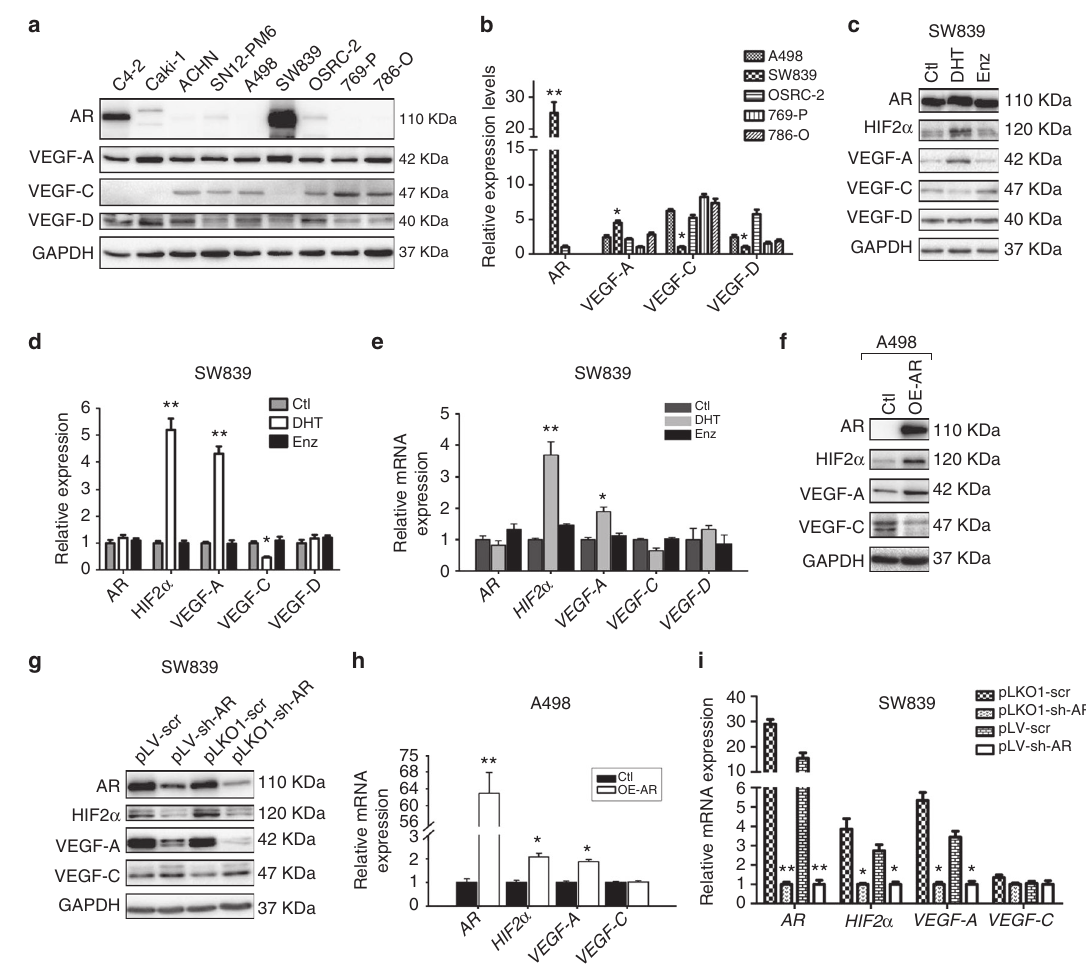
Fig. 2 AR differentially regulates the VEGF-A vs. VEGF-C in ccRCC cells. a Protein expressions of AR, VEGF-A, VEGF-C, and VEGF-D were detected by western blot in a series of ccRCC cell lines (SN12-PM6, Caki-1, ACHN, A498, SW839, OSRC-2, 769-P, and 786-O). The prostate cancer cell line C4-2 expressing AR was used as positive control. b Quantitation of protein expressions of AR, VEGF-A, VEGF-C, and VEGF-D in triplicate western blot assays of VHL mutant cell lines (A498, SW839, OSRC-2, 769-P, and 786-O). c Immunoblotting of HIF2 α , VEGF-A, VEGF-C, and VEGF-D following 48 h DHT and Enz treatment in SW839 cell line. d Quantitation of protein expressions of AR, VEGF-A, VEGF-C, and VEGF-D in triplicate western blot assay. e The mRNA levels of HIF2 α , VEGF-A, and VEGF-C following 24 h DHT and Enz treatment in SW839 cells. f Western blotting of HIF2 α , VEGF-A, and VEGF-C in A498 cells with/without AR overexpression (OE-AR). g We used two different sh-RNAs (pLKO1-sh-AR and pLV-sh-AR) to knockdown AR in SW839 cells. The results showed that both sh-RNAs could effectively suppress AR. Moreover, HIF2 α and VEGF-A were decreased yet VEGF-C was increased. h , i The mRNA levels of HIF2 α , VEGF-A, and VEGF-C in cells with/without AR overexpression in A498 cells ( h ) and AR knockdown in SW839 cells ( i ), TBP was used as an internal loading control. Triplicate experiments were carried out to detect mRNA and protein expressions. * p < 0.05, ** p < 0.01, were considered statistically signi fi cant by t